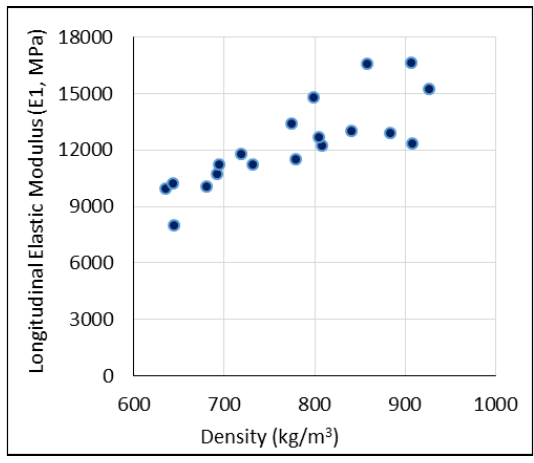
Table 3. The material properties of specimens.